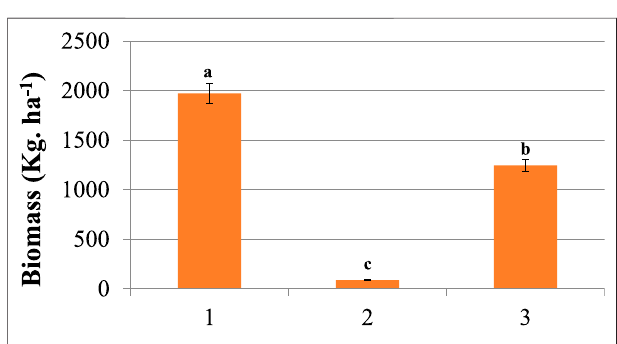
FIGURE 6 | Comparison of seasonal grass biomass production of the selectively thinned savanna of southern Ethiopia. Season code: # 1 (cid:2) Season 1; # 2 (cid:2) Season 2, and # 3 (cid:2) Season 3. The presence of signi fi cant difference among seasons is indicated by different letters. Vertical bars mean a 0.95 con fi dence